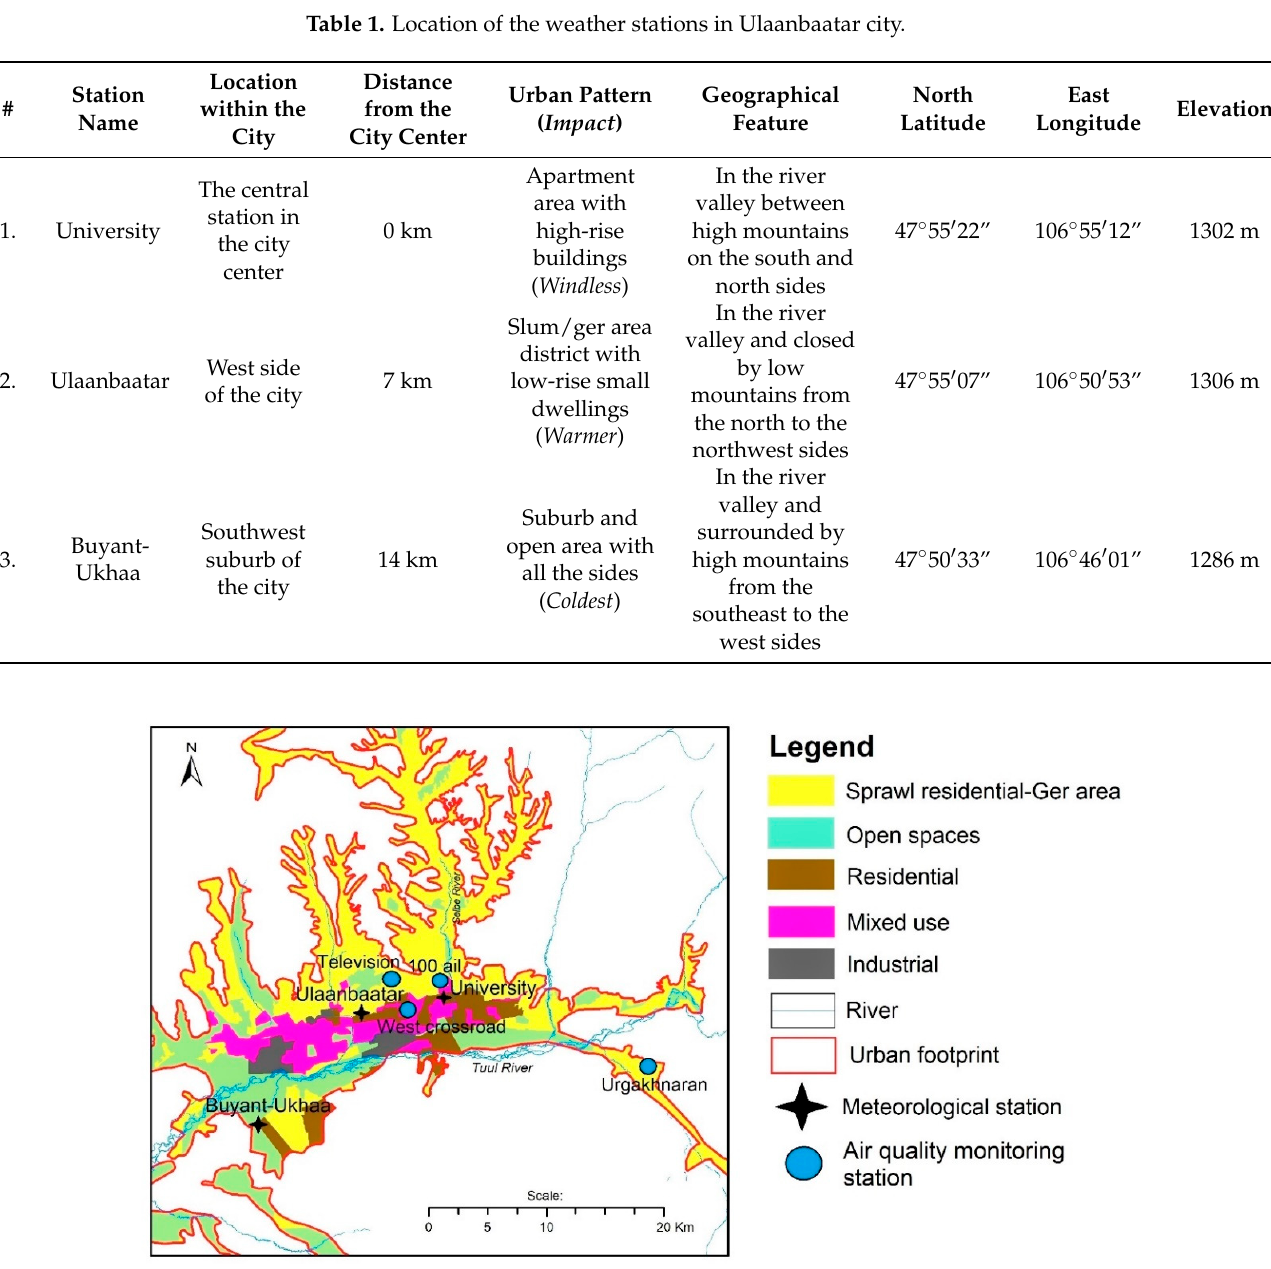
Figure 2. Locations of weather and air quality monitoring stations in Ulaanbaatar city. Since spatiotemporal distributions of temperature, moisture, and wind are the com- Table 1. Location of the weather stations in Ulaanbaatar city. bined result of topographic and atmospheric circulation conditions [29], atmospheric stagnation conditions and air pollution potential were studied using radiosonde data from 2012 to 2020 at the Ulaanbaatar station. The radiosonde provides air temperature, pres- sure, humidity, wind speed, and direction at different levels. Near-surface temperature inversion and atmospheric ventilation coefficient (VC) indicate a stagnation condition and air pollution potential, respectively [30,44]. Near-surface temperature inversion thickness, intensity and frequency were calculated from daily radiosonde data (00:00 UTC and 12:00 UTC) using a method based on hydrostatic and state equations, which were applied by Sumiya [30] and Wang et al. [22] and analyzed